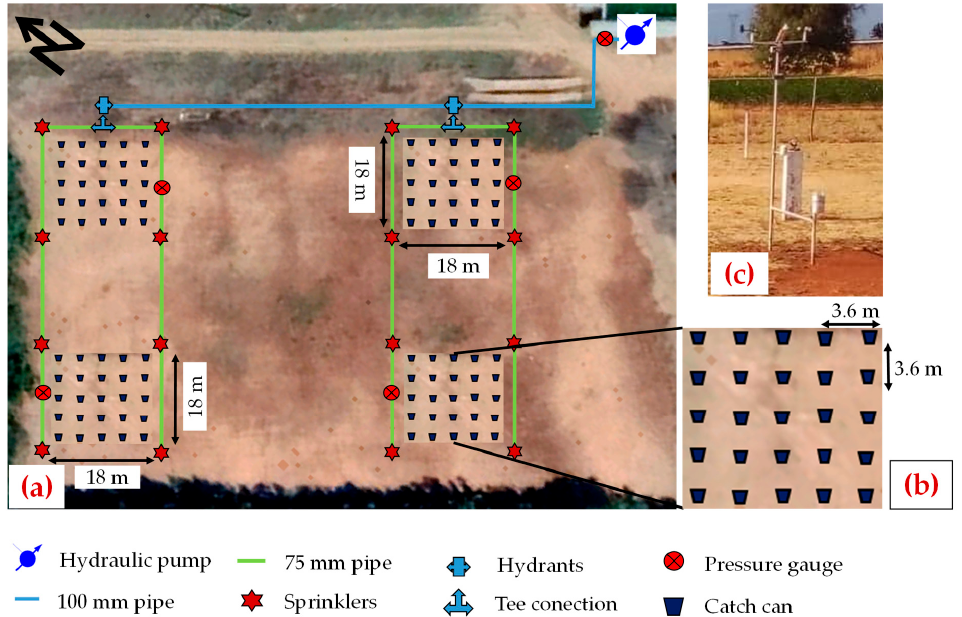
Figure 2. Experimental setup for computing the irrigation performance indexes. Solid-set configu- ration ( a ), catch can configuration ( b ) and automated agrometeorological station ( c ). The operating pressure was supervised in all the tests with a glycerin pressure gauge. Four sprinklers of the same type were installed in each of the four subplots. At the same time, 16 sprinklers were operated in the plot (Figure 2a). The irrigation system operated with one pressure till the number of proposed measurements were achieved. The number of tests for each sprinkler depended on reaching the water application patterns with three different wind velocities with ranges: ≤ 2 m/s, 2 m/s to 4 m/s and greater than 4 m/s. The experiments were performed between 31 July and 15 August 2021 from 7:30 am to 5:00 pm in order to obtain a full characterization along the day. The system was operated for 2 h at each irrigation event. The sprinklers were installed at a height of 0.6 m AGL. The water application distribution was assessed with a 25 catch-can grid in each sub- plot distributed homogeneously on the area of 324 m 2 with 3.6 m × 3.6 m between the sprinklers and the pipelines, respectively, (Figure 2b) following the methodology of Playán et al. [23]. The catch-can grids remained in each subplot during all the experiments. The irrigation events lasted for two hours. The catch-can water depth was measured using a cylinder graduated in milliliters in all subplots. Therefore, the volume in milliliters of each catch can was converted to irrigation depth in millimeters per hour considering the catch-can influence area (3.6 m × 3.6 m) and the irrigation time (2 h). The pluviometers used are made of plastic with 0.11 m upper diameter, 0.09 m lower diameter, 0.07 m height and 0.5 L maximum capacity. The catch cans were located at ground level, leaving a 0.51 m height from the pluviometer mouth to the sprinkler nozzle, the previous catch-can fea- tures were consistent with ISO 15886-3 [13]. The irrigation depth obtained per experiment was used to determinate the Distribution Uniformity (DU, %) [15] (Equation (1)) and Christiansen’s Uniformity Coefficient (CUC, %) [16] (Equation (2)).